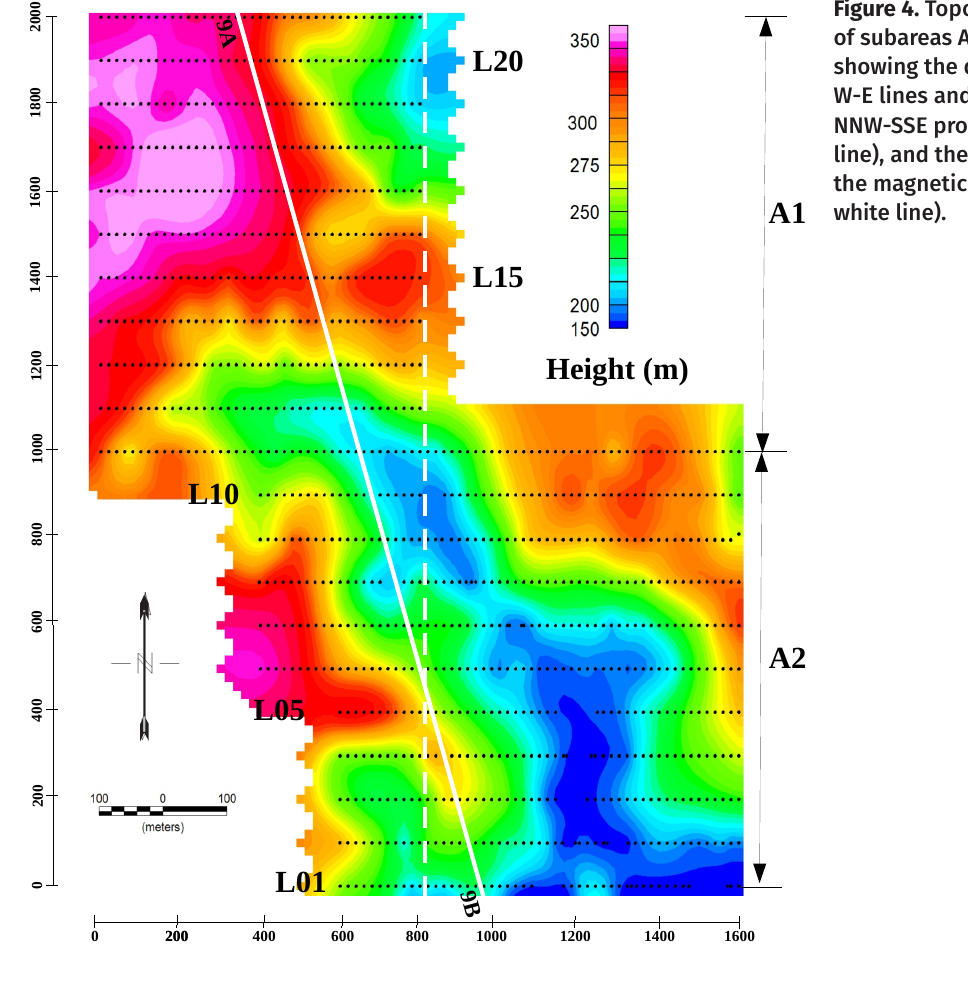
Figure 4. Topographic map of subareas A1 and A2 showing the distribution of W-E lines and stations, the NNW-SSE profile (white solid line), and the N-S tie-line for the magnetic data (dashed white